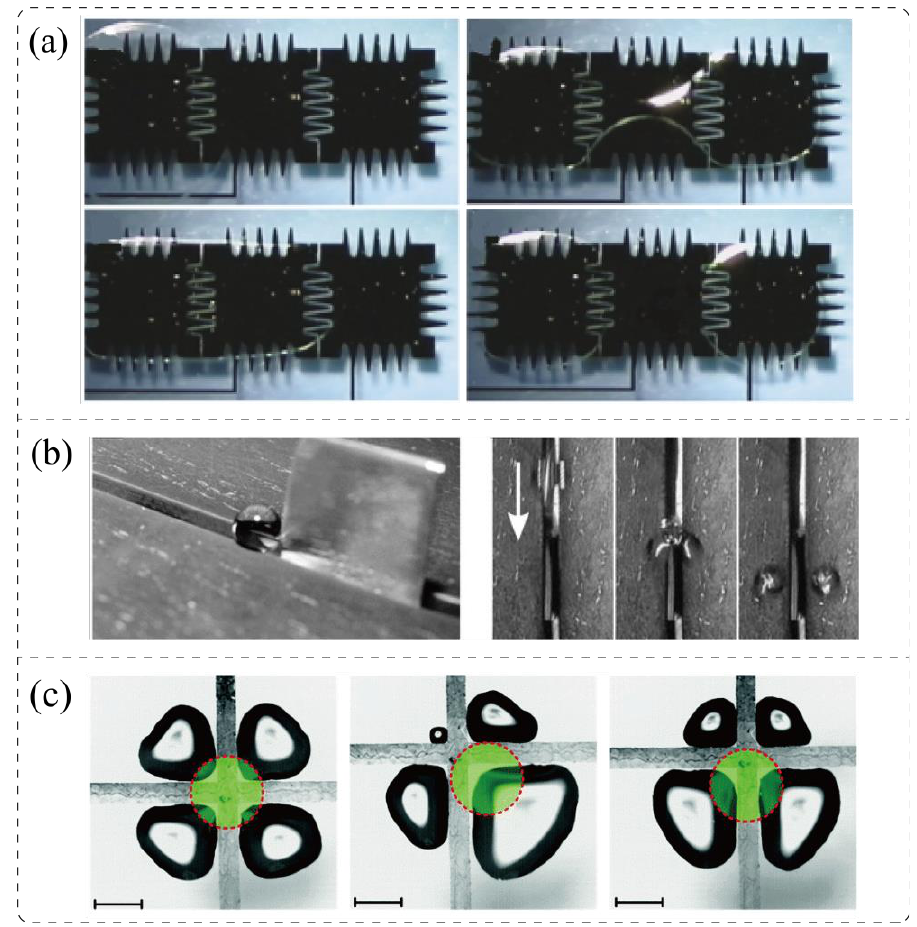
Figure 15. ( a ) Separation process of liquid droplets by electrode switching [141] (Reproduced with permission from Royal Society of Chemistry 2002). ( b ) Schematic of gravity-actuated droplets being divided into two parts by a superhydrophobic knife [142] (Reproduced with permission from John Wiley and Sons, 2011). ( c ) The snapshots of a big droplet split into multiple small droplets by superhydrophobic stripes. The green shadows circled by red dots show the size and initial landing position of the big droplet, with a scale bar of 2 mm [143] (Reproduced with permission from the Royal Society of Chemistry, 2015).